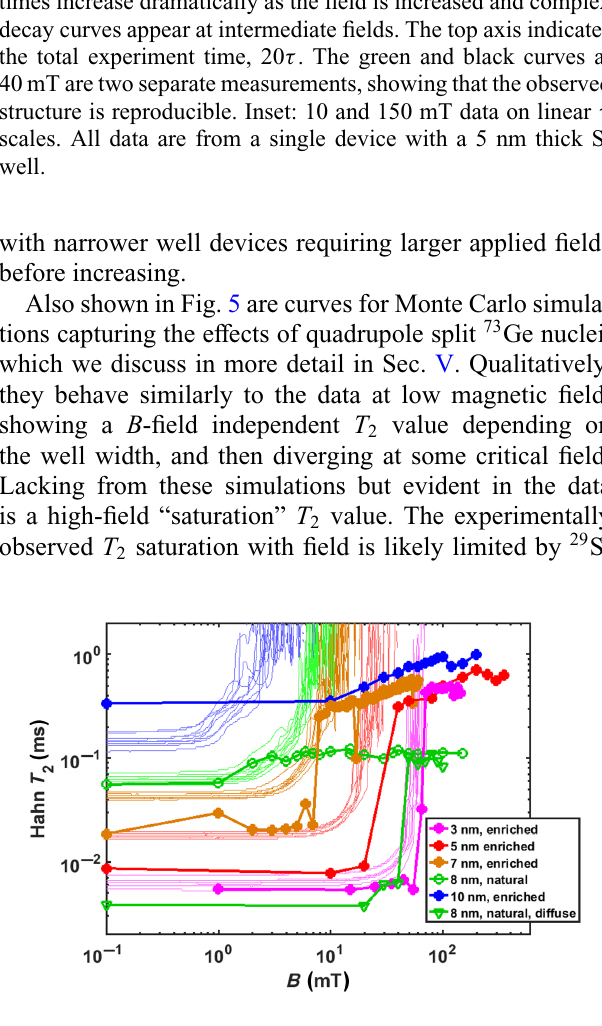
FIG. 5. Hahn echo T 2 as determined by the 1 / e decay time versus well width and applied magnetic field. Thick lines and symbols are experimental measurements across six devices; thin lines are results of simulations for ten devices at each well width with varying random 73 Ge